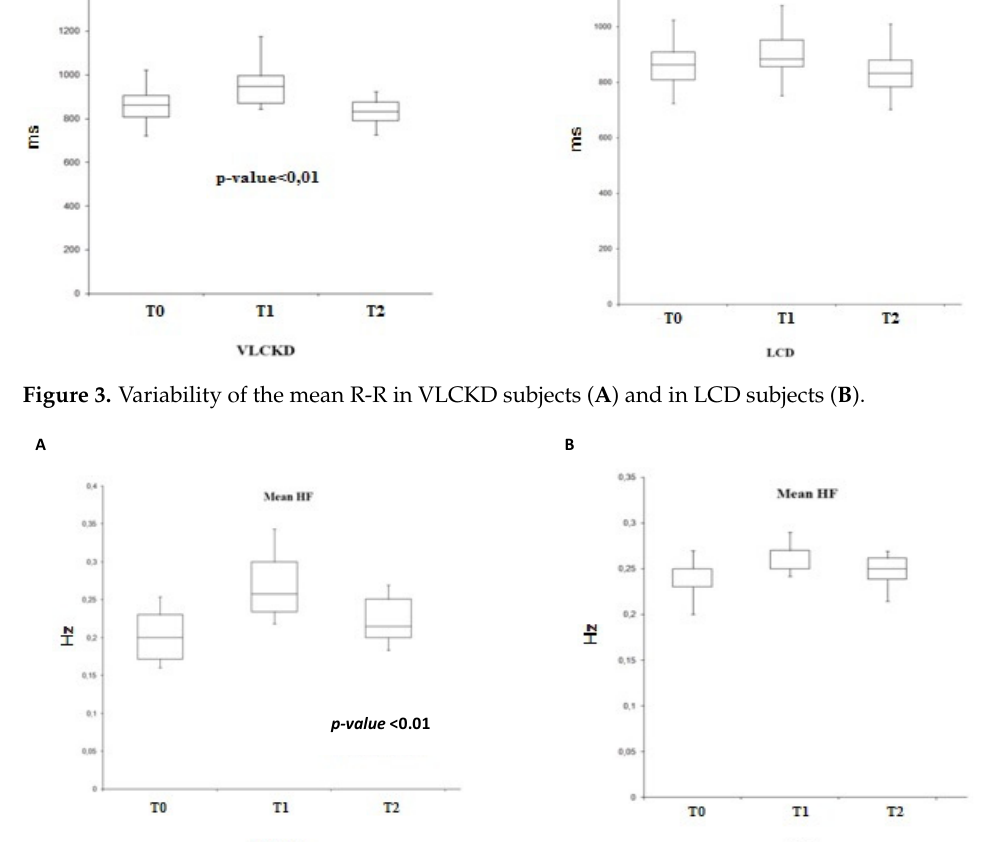
p-value <0.01 Figure 4. Variability of the mean HF in VLCKD subjects (A) and in LCD subjects (B).